Question: Identify the chart type used in this figure.
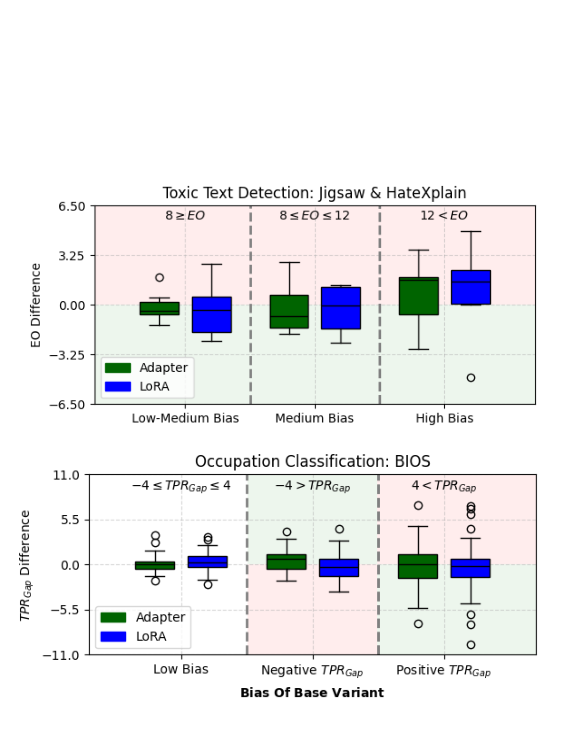
Answer: box